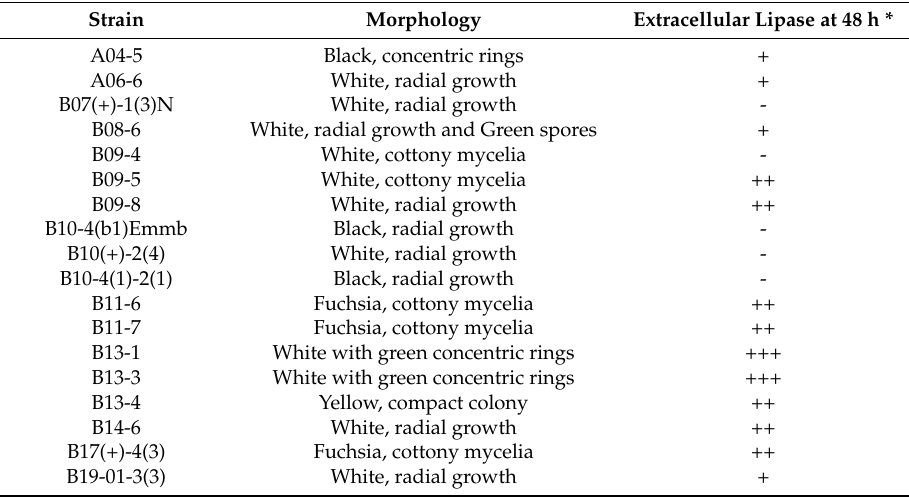
Fungi isolated in this study from banana plant residue and used for screening of lipolytic activity. Strain Morphology Extracellular Lipase at 48 h * A04-5 Black, concentric rings + A06-6 White, radial growth + B07(+)-1(3)N White, radial growth - B08-6 White, radial growth and Green spores + B09-4 White, cottony mycelia - B09-5 White, cottony mycelia ++ B09-8 White, radial growth ++ B10-4(b1)Emmb Black, radial growth - B10(+)-2(4) White, radial growth - B10-4(1)-2(1) Black, radial growth - B11-6 Fuchsia, cottony mycelia ++ B11-7 Fuchsia, cottony mycelia ++ B13-1 White with green concentric rings +++ B13-3 White with green concentric rings +++ B13-4 Yellow, compact colony ++ B14-6 White, radial growth ++ B17(+)-4(3) ++ B19-01-3(3) White, radial